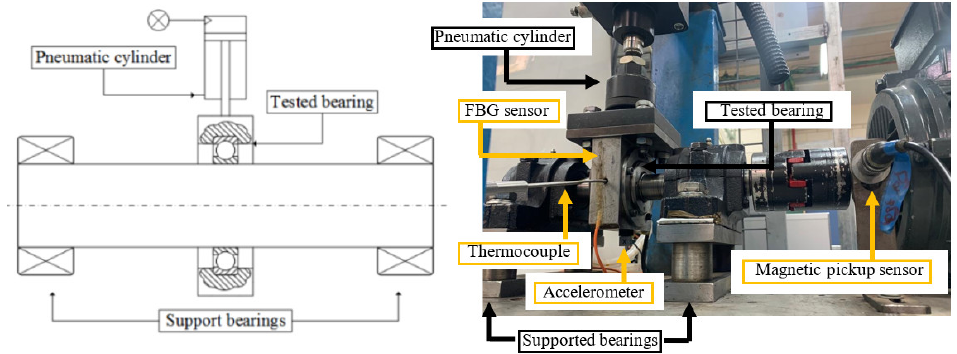
Figure 3. A schematic drawing and a picture of the test